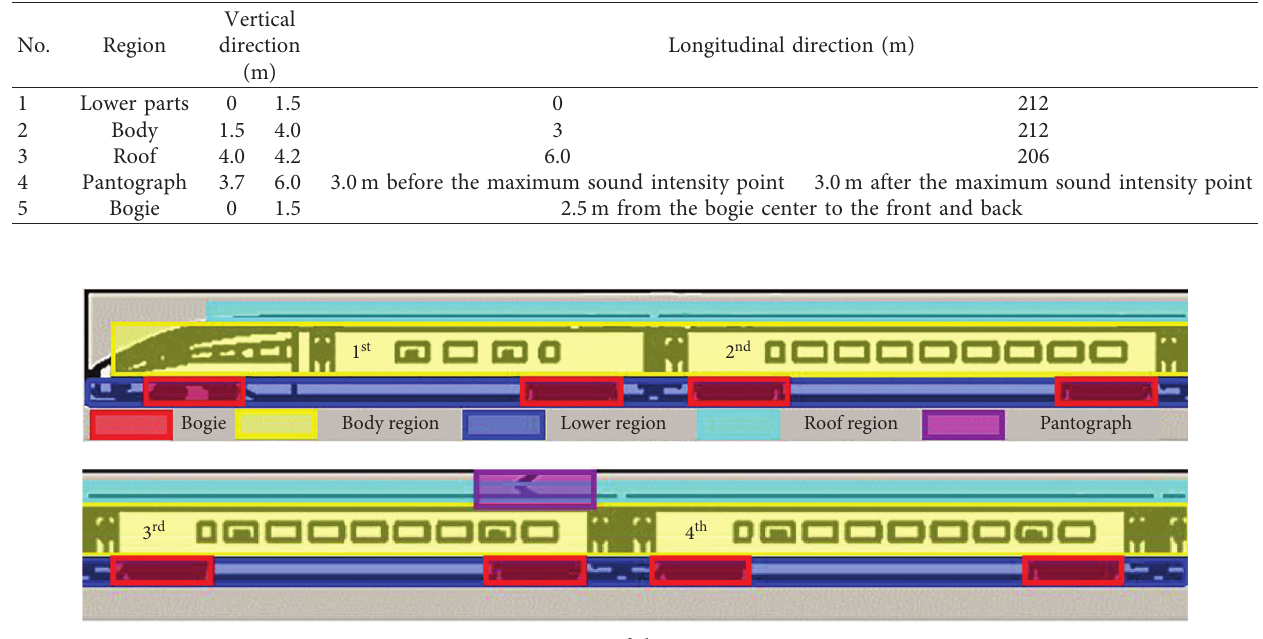
Figure 5: Division of the train into regions.